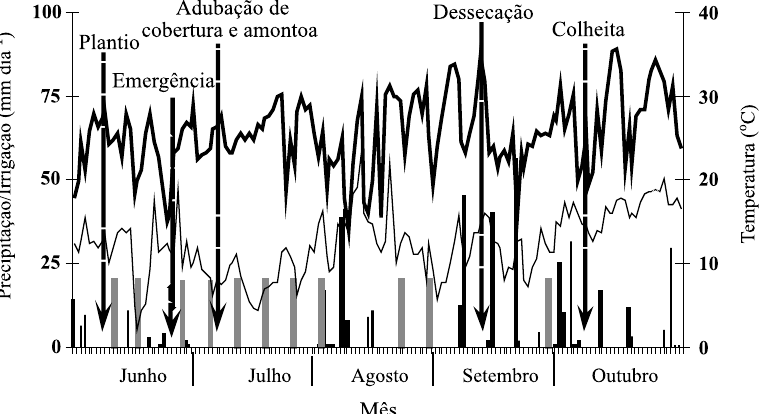
Figura 1. Precipitação pluvial ( ), irrigação ( ), temperaturas máximas ( ) e mínimas ( ) registradas na área do experimento, durante o período de junho a outubro de